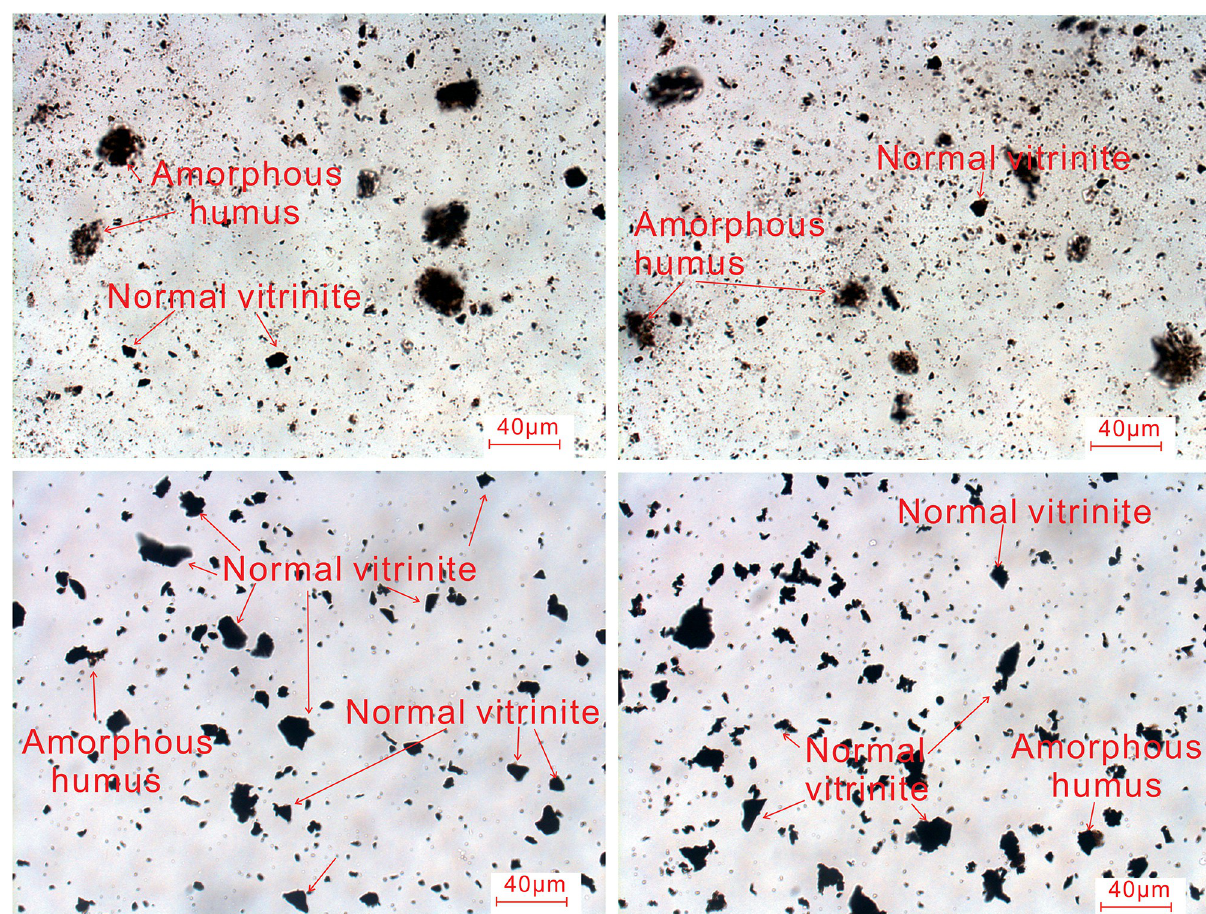
Fig 4. Photomicrographs of typical organic material in Longtan Formation